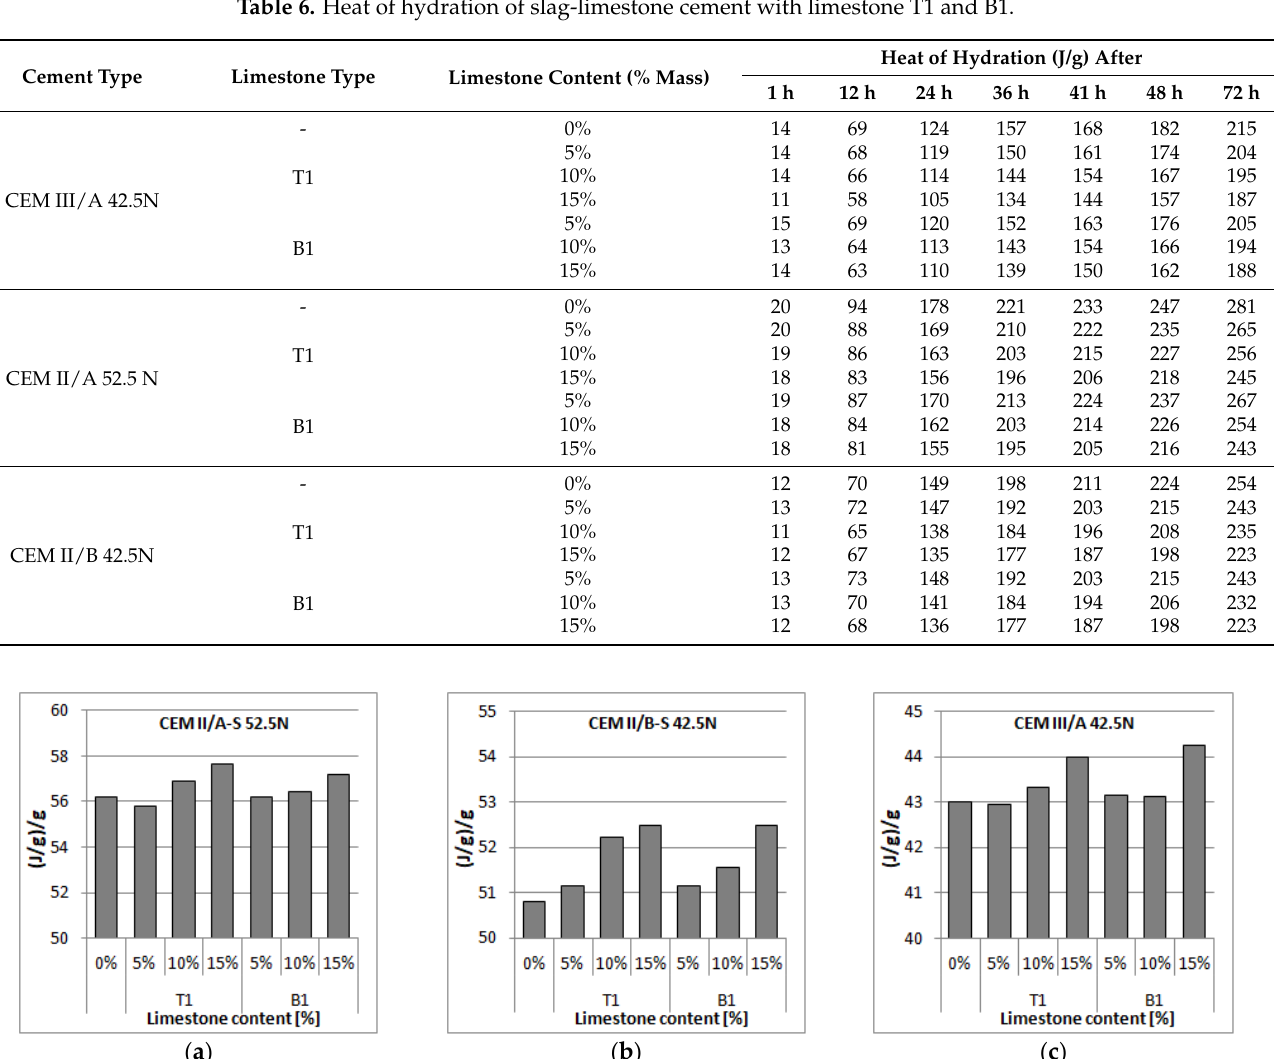
Figure 7. The ratio of the total heat of the slag-limestone cement hydration after 72 h to the weight content of slag cement in multi-component slag-lime cements with ( a ) CEM II/A-S 42.5N, ( b ) CEM II/B-S 42.5N, ( c ) CEM III/A 42.5N cement.